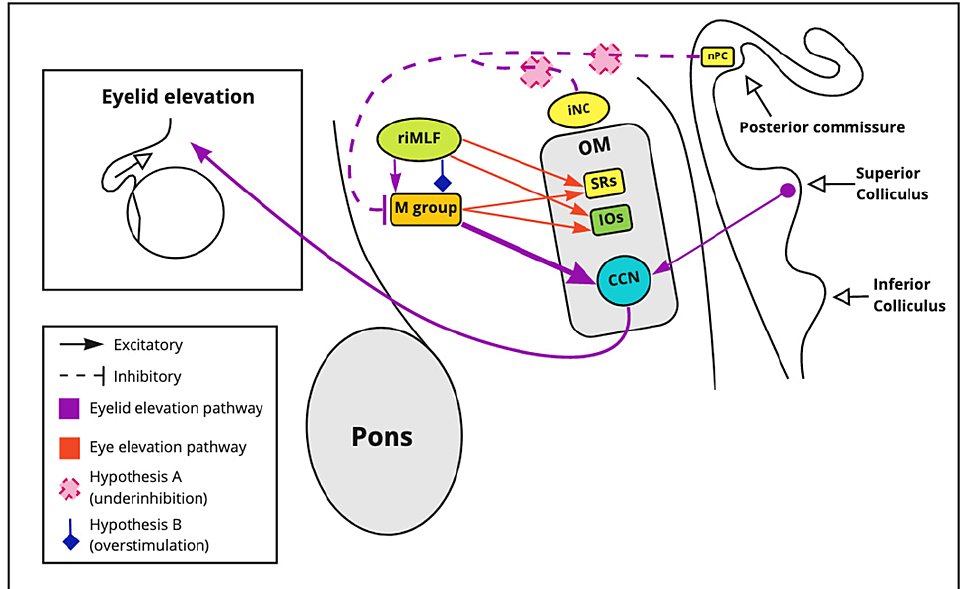
Figure 3. Collier’s sign. The posterior commissure elicits the pupillary reflex, generates the eyes’ vertical movement, and inhibits the upper eyelid elevation pathway. Lesions in the iNC tend to alter M and CCN-group cells. The M-group and riMLF sends excitatory output to the superior rectus (SR), inferior oblique (IO) muscles, and facial nucleus (frontalis muscle), and levator palpebrae which generate eyelid elevation. When M-group cells are stimulated, the firing rate in the CCN increases, as well. Overstimulation or under inhibition of the M group is the proposed hypothesis. Supranuclear control impairment may trigger an overstimulation of the M group by increasing the CCN firing rate. Another hypothesis states that a lesion or damage in the inhibitory nPC and the iNC limits inhibition of the M group. nPC: nuclei of the posterior commissure, iNC: interstitial nucleus of Cajal, riMFL: rostral interstitial nucleus of medial longitudinal fasciculus, OM: oculomotor nuclei, SRs: paramedian nucleus, IOs: intermediate columns nucleus, CCN: central caudal nuclear.